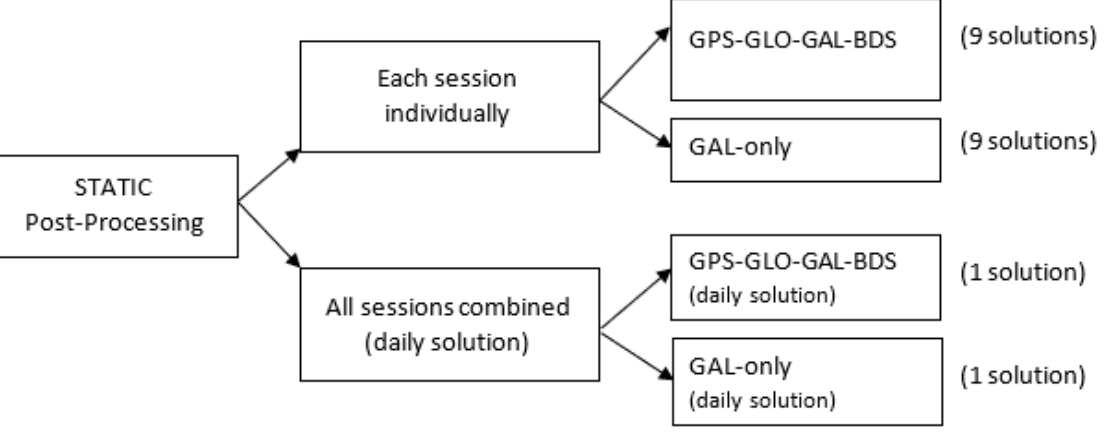
Figure 4. Static post-processing schema in TBC: each session was processed providing solutions based on GGGB and GAL-only observation data.